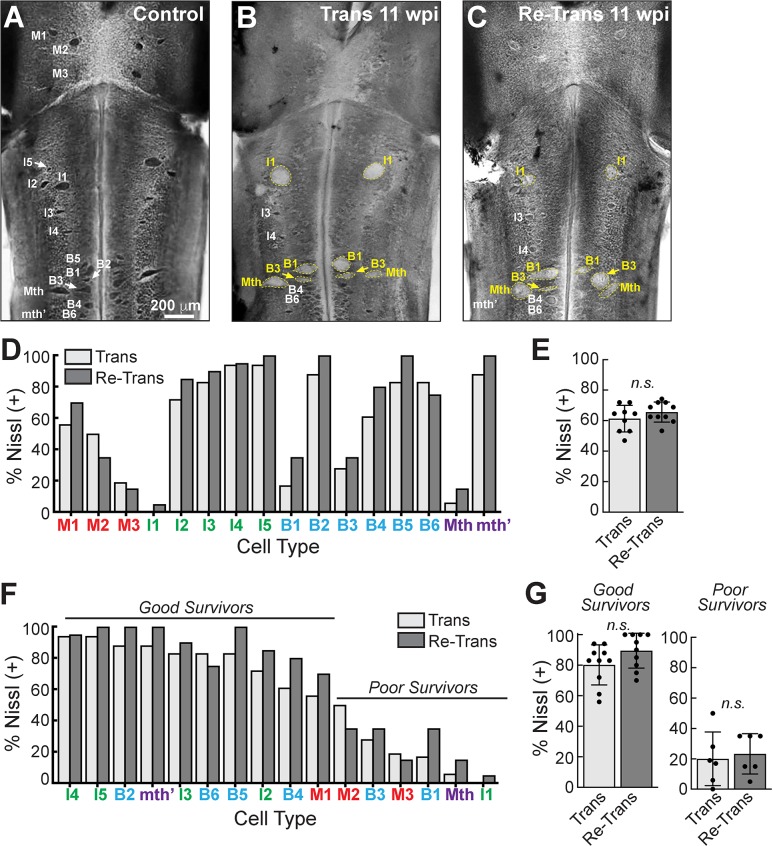
Nissl staining of giant RS neurons is comparable at 11 wpi after spinal transection and re-transection.(A) A whole mounted control lamprey brain stained with Toluidine blue O, which labels Nissl substance within healthy neurons. All giant RS neurons are labeled. Scale bar in A also applies to B-C. (B-C) In contrast, at 11 wpi after spinal transection and re-transection only a subset of neurons retains strong Nissl staining (white labels), indicating surviving neurons. Other neurons become chromalytic, swell, and lose their Nissl substance (yellow labels), indicating neurodegeneration. (D) Cell-by-cell analysis of Nissl (+) giant RS neurons from n = 10 lampreys. (E) The percentage of total giant RS neurons that was Nissl (+) was similar in transected and re-transected lampreys. (F-G) “Good survivor” and “poor survivor” populations of giant RS neurons exhibited similar degrees of Nissl (+) staining. Bars in E and G represent mean ± SD per brain from n = 10 lampreys. n.s. indicates “not significant” by Students t-Test (p>0.05).